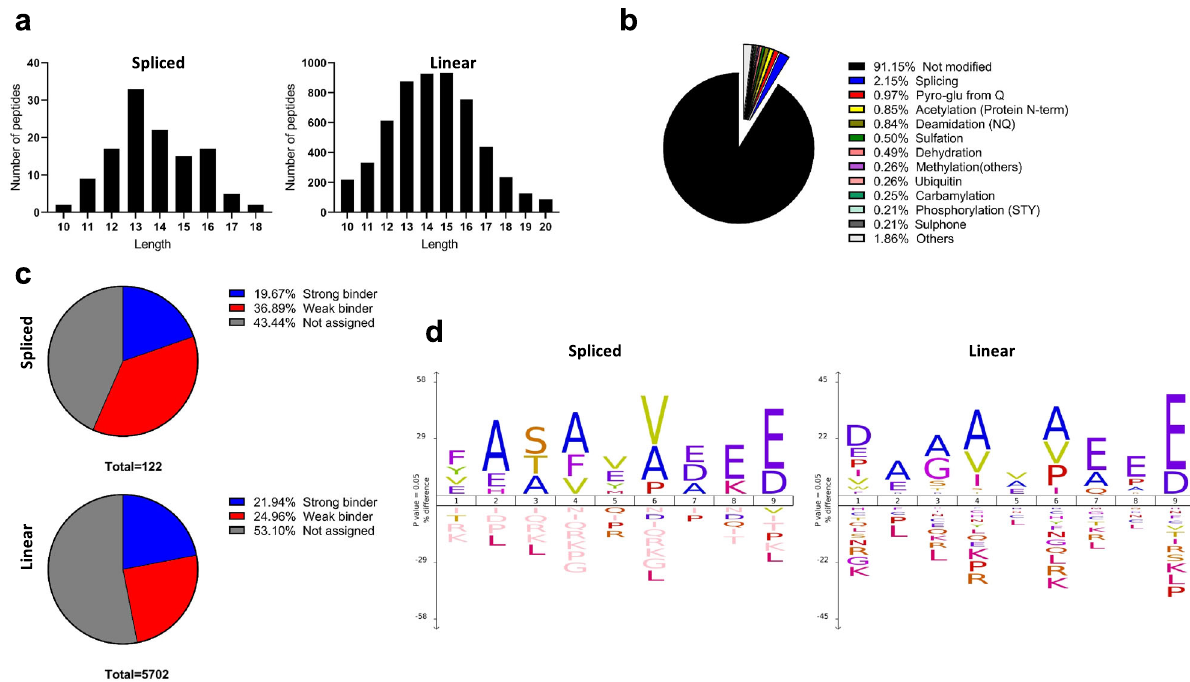
Fig. 1 Spliced peptides in the HLA-DQ8 peptide repertoire. Peptide ligands identi fi ed from immunoaf fi nity puri fi ed HLA-DQ8 isolated from 9033 cells showing: a spliced and linear peptide length distributions; b Proportion and types of PTMs observed in peptidome; c Estimated HLA-DQ-8 af fi nity of spliced and linear peptides; d spliced and linear peptide core-binding 9-mer